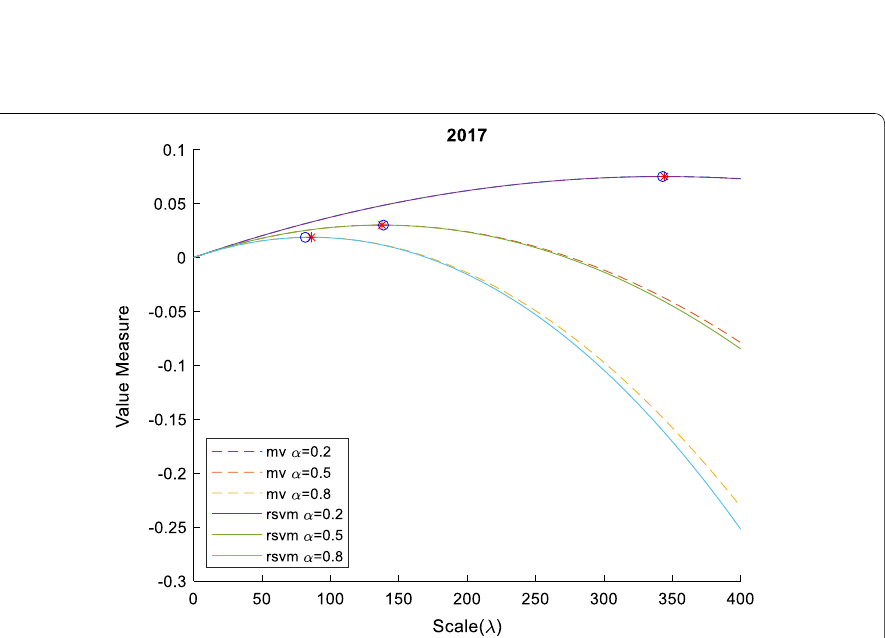
Fig. 4 Value measure of RSVM and MV with various risk aversion α and scale (cid:31) in 2017. This figure shows the relation between value measure (mean–variance model with dash line and risk‑sensitive value measure with line) and scale with different investors (risk‑averter α = 0.8 , risk‑neutral α = 0.5 , and risk‑seeker α = 0.2 ) in 2017. The red star and blue circle are optimal scale of mean–variance model and risk‑sensitive value measure,